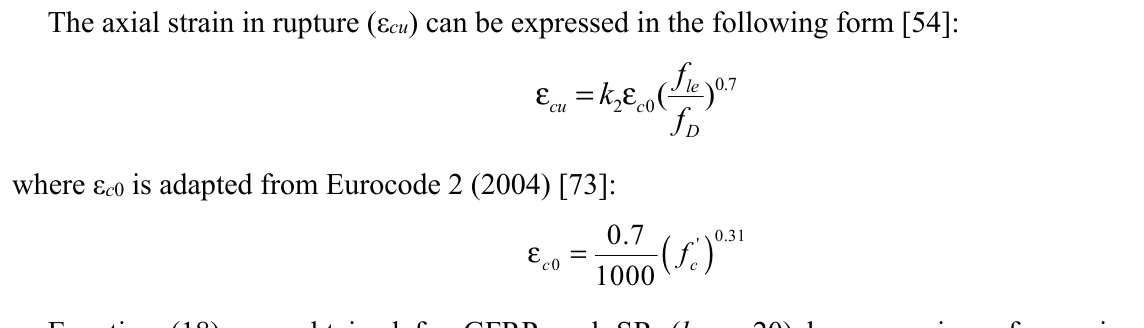
Figure 13. Relationship between f cu , f D and f le of concrete cylinders confined with GFRP and SR.